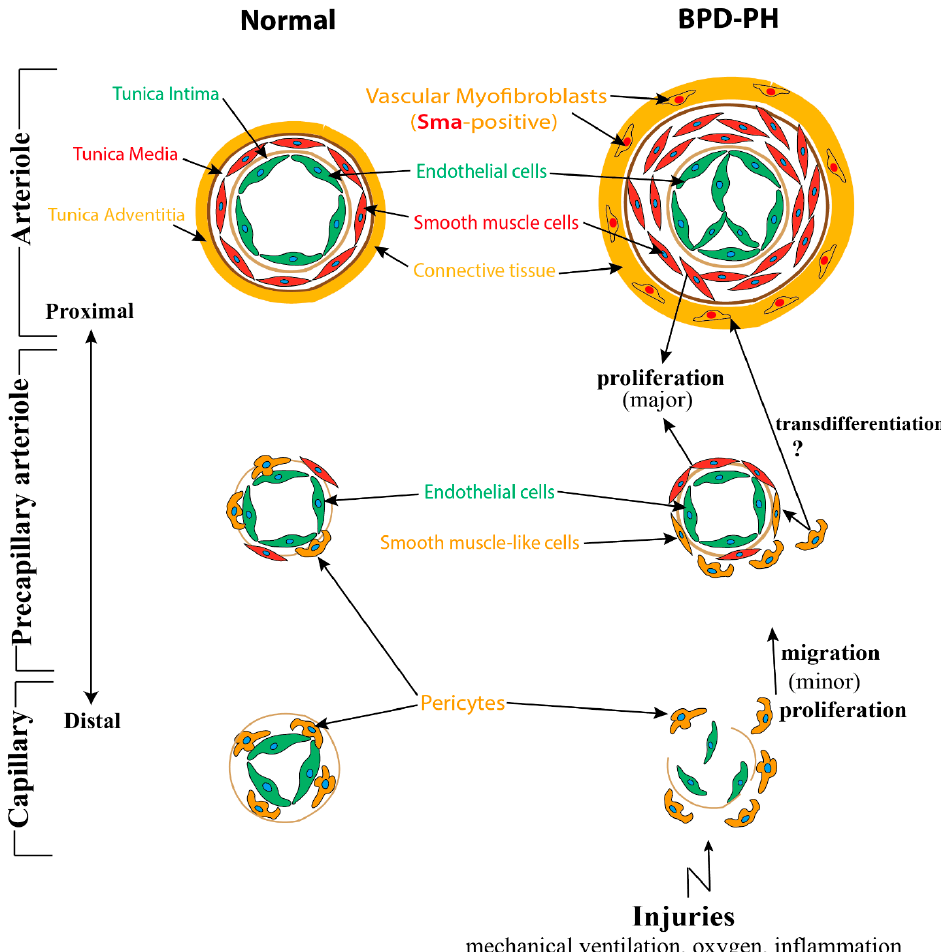
Figure 1. A speculative model of structural changes of the pulmonary vessel wall in bronchopulmonary dysplasia-associated pulmonary hypertension (BPD-PH). Under a normal situation, pulmonary arterioles are wrapped by the following three layers of tunicae: The tunica intima consists of endothelium, basement membrane, and internal elastic tissue; the tunica media is comprised of smooth muscle cells and external elastic tissue; and connective tissues constitute the tunica adventitia. From large vessels to small vessels, tunica media and adventitia are gradually getting sparse and the smooth muscle cells gradually evolving into pericytes, which adhere tightly to capillary endothelial cells (ECs). While in BPD, due to multifactorial injuries, the endothelial cells are dysfunctional and eventually become apoptosis resistant. Smooth muscle cells, which mostly proliferated from resident smooth muscle cells (SMCs) are increased significantly, resulting in the thickening of tunica media and the muscularization of normally non-muscular vessels. Adventitia of pulmonary arterioles undergo α -Sma positive myofibroblast transition assisted by altered extracellular matrix breakdown and deposition. Pericytes disconnect with capillary ECs, leading to the loss of small capillaries, proliferate, and migrate into the mesenchyme and also contribute to a small population of smooth muscle-like cells. Pericytes play a critical role in regulating microvascular and alveolar development. Pericytes, on the one hand, adhere to capillary ECs to regulate their function, proliferation, migration, and differentiation via several signaling pathways including Vegf/Vegfr, Pdgfb/Pdgfrb2, Tgf β /Alk,